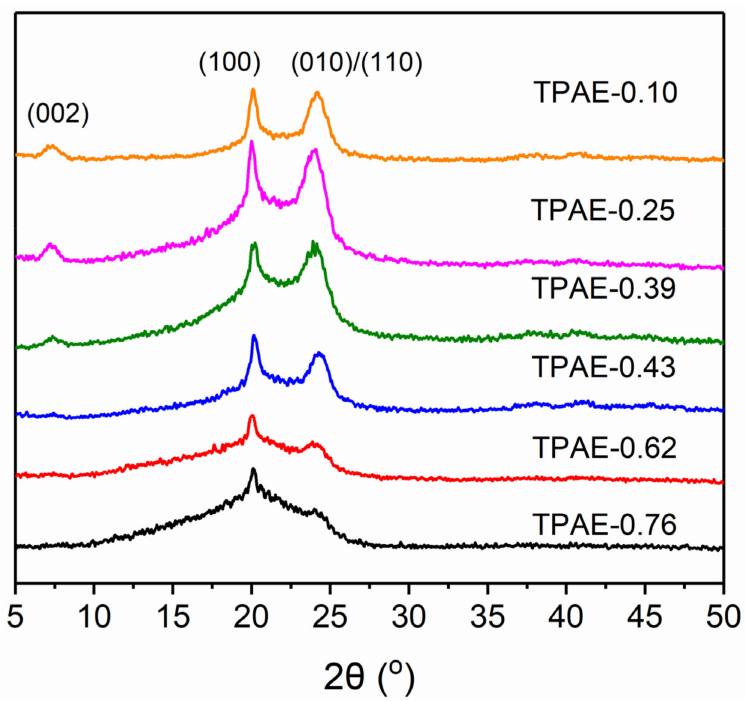
Figure 5. WAXD patterns of the TPAEs at ambient